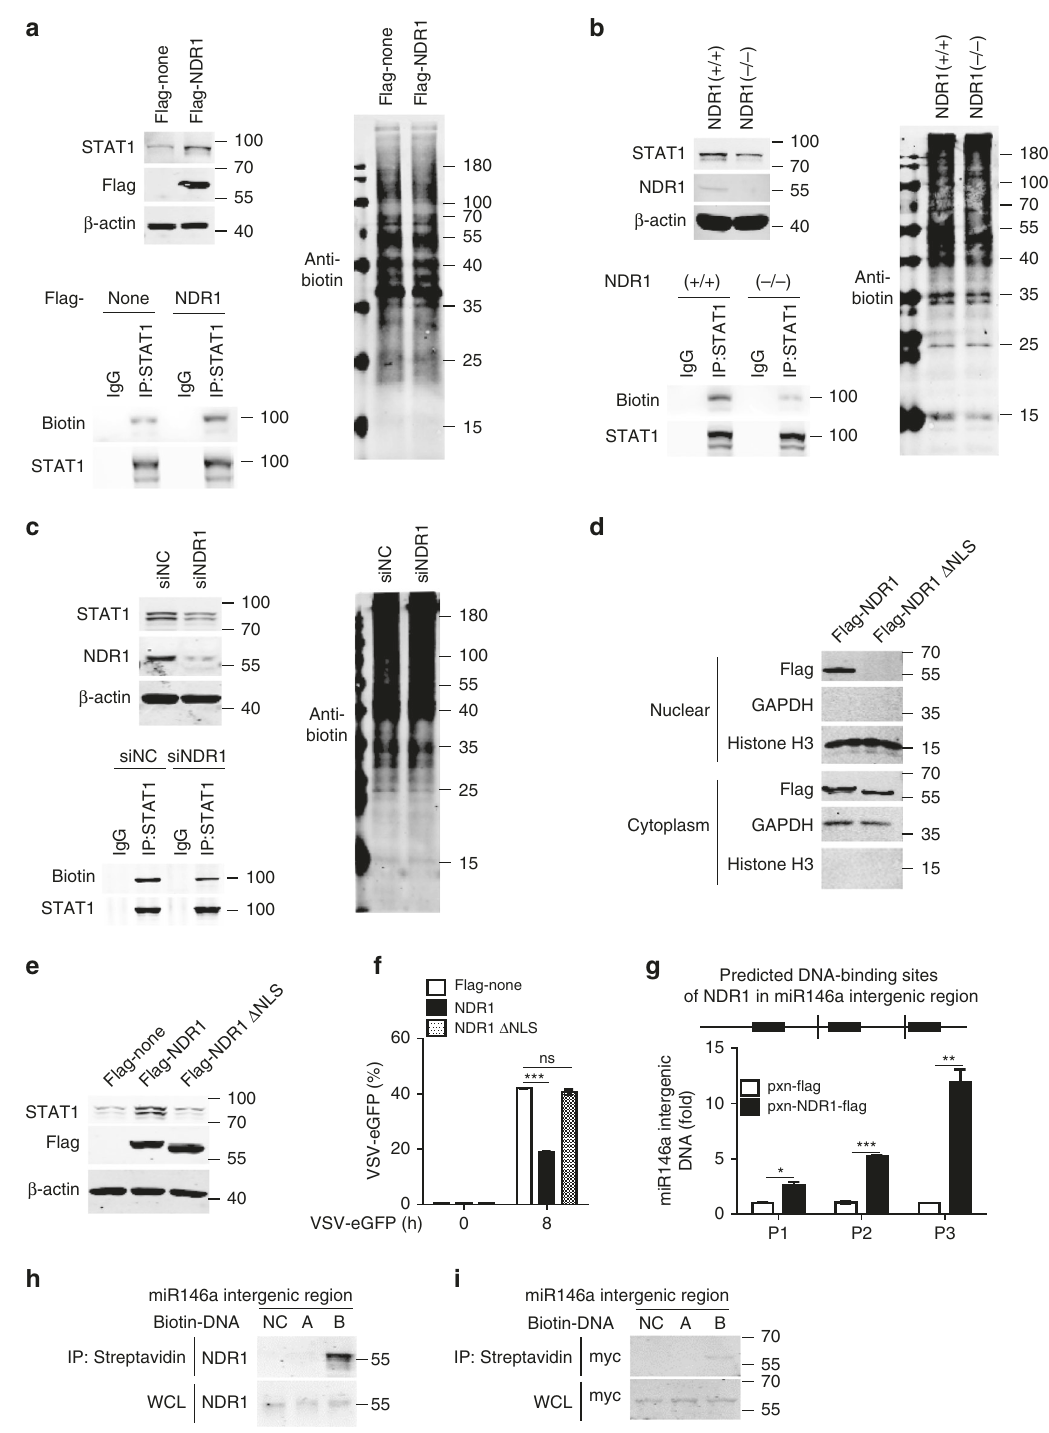
Fig. 6 Nuclear NDR1 promotes STAT1 translation. a − c RAW264.7 cells stably expressing fl ag-NDR1 or control transfectants ( a ), WT or NDR1 − / − PMs ( b ), NDR1 silencing PMs ( c ), were treated with metabolic labeling reagents (AHA). Subsequently corresponding cell lysates were labeled with biotin for nascent proteins via azide/alkyne reaction, followed by immunoprecipition with anti-STAT1 antibody or nonspeci fi c IgG. d Immunoblot analysis of fl ag-tagged full-length NDR1 or NDR1 Δ NLS mutant expression in cytoplasmic and nuclear fractions from RAW264.7 cells stably expressing fl ag-NDR1 or fl ag-NDR1 Δ NLS mutant. e Immunoblot analysis of STAT1 expression in RAW264.7 cells stably overexpressing NDR1, NDR1 Δ NLS mutant or empty vector. f FACS analysis of RAW264.7 cells as in e infected with VSV-eGFP. g ChIP-qPCR analysis of the enrichment of NDR1 to miR146a intergenic region with anti- fl ag M2 magnetic beads in lysates of RAW264.7 cells stably expressing fl ag-NDR1 or control transfectants. h Biotin-labeled DNA was incubated with lysates of PMs for 30min at 25°C. Streptavidin sepharose beads were then added and incubated for another 30min. The beads were washed and then resolved by 2× SDS loading buffer for immunoblotting. i Biotin-labeled DNA (miR146a intergenic region or control DNA) and puri fi ed myc-NDR1 protein were incubated in DNA pull-down buffer for 30min at 25°C. Streptavidin sepharose beads were then added and treated as in h for immunoblotting. Data are mean±SD and are representative of three independent experiments. Student ’ s t test was used for statistical calculation. * p <0.05, ** p <0.01, *** p <0.001. See also Supplementary Fig.